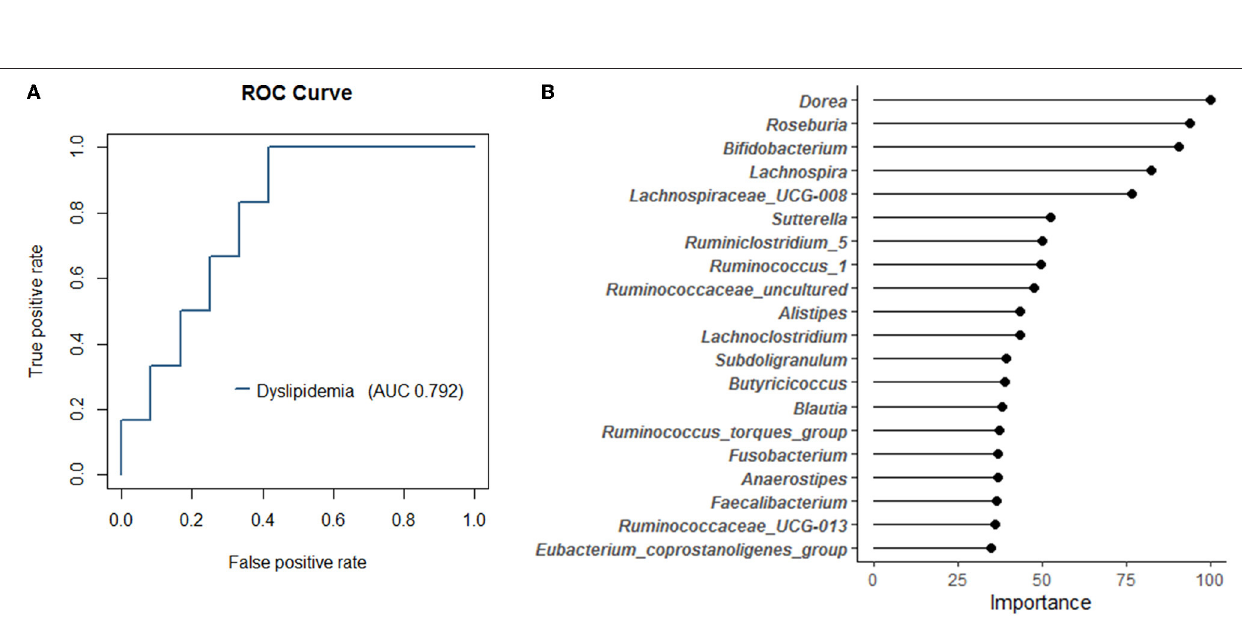
FIGURE 4 | The random forest classification model generated based on 50 genera in the training data set. (A) The receiver operating characteristic (ROC) curves and area under curve (AUC) of the microbiome for discrimination between responders and non-responders. (B) The top 20 explanatory variables that are important for the classification